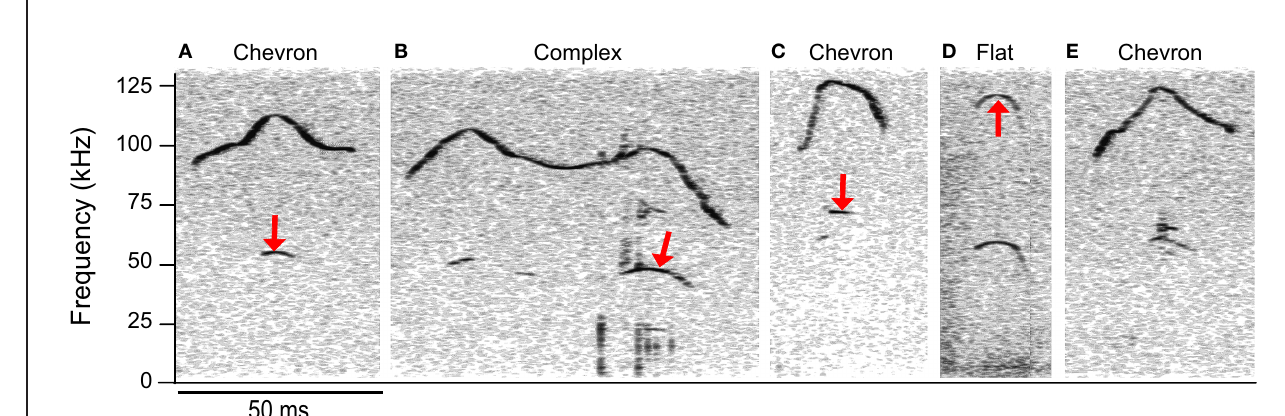
FIGURE 8 | Discrepancies between automated and manual analyses. The manual classification is shown above each spectrogram. Syllables (A–D) were erroneously classified as having 2 frequency steps and were allocated to the c2 cluster. Red arrows indicate the points during each syllable where the automated extraction of the contour was not the same point on the spectrogram that the trained investigator would have chosen. Seventy-eight